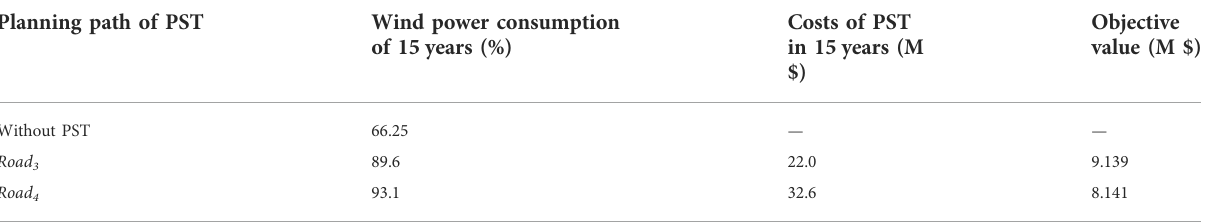
TABLE 4 IEEE 118-bus system results of Road 3 and Road 4 .